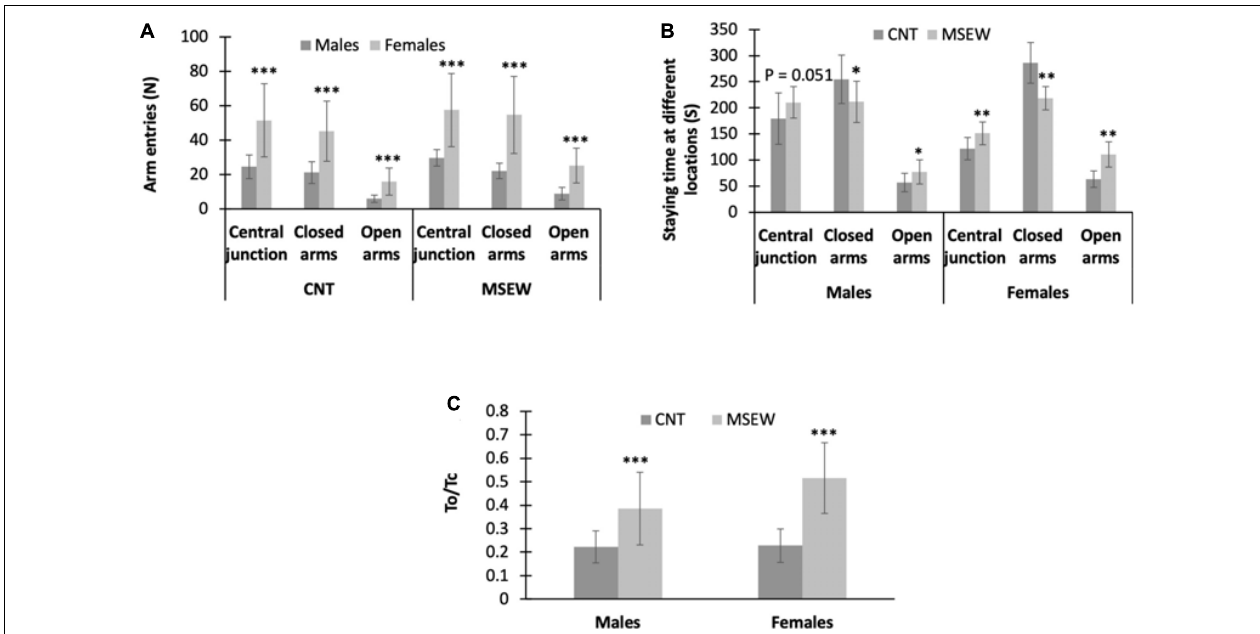
FIGURE 5 | Performance of rats on elevated-plus maze. (A) The comparisons between males and females in either CNT or MSEW rats, in terms of the number of entries into different parts of the elevated-plus maze. (B) The comparisons between CNT and MSEW rats in either gender, in terms of the time spent at different parts of the elevated-plus maze. (C) The comparisons between CNT and MSEW rats in either gender, in terms of To/Tc ratio. Data were expressed as mean ± SD. n = 15/group. * p < 0.05, ** p < 0.01, *** p <